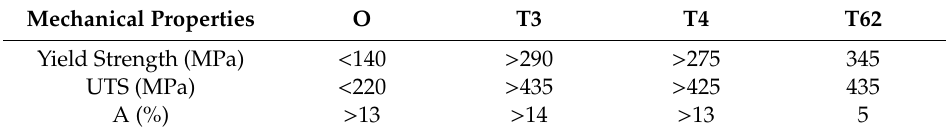
Table 1. Mechanical properties of EN AW-2024 in di ff erent heat treatment conditions